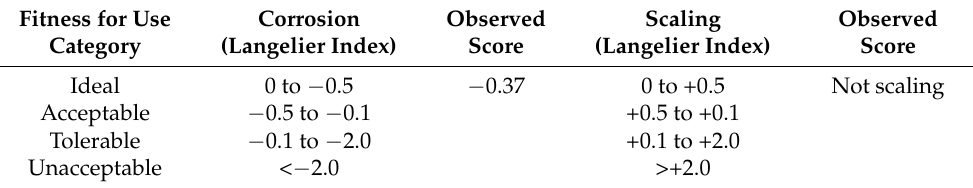
Table 8. Fitness for Use Category determined by the corrosion or scaling potential indicated by the Langelier